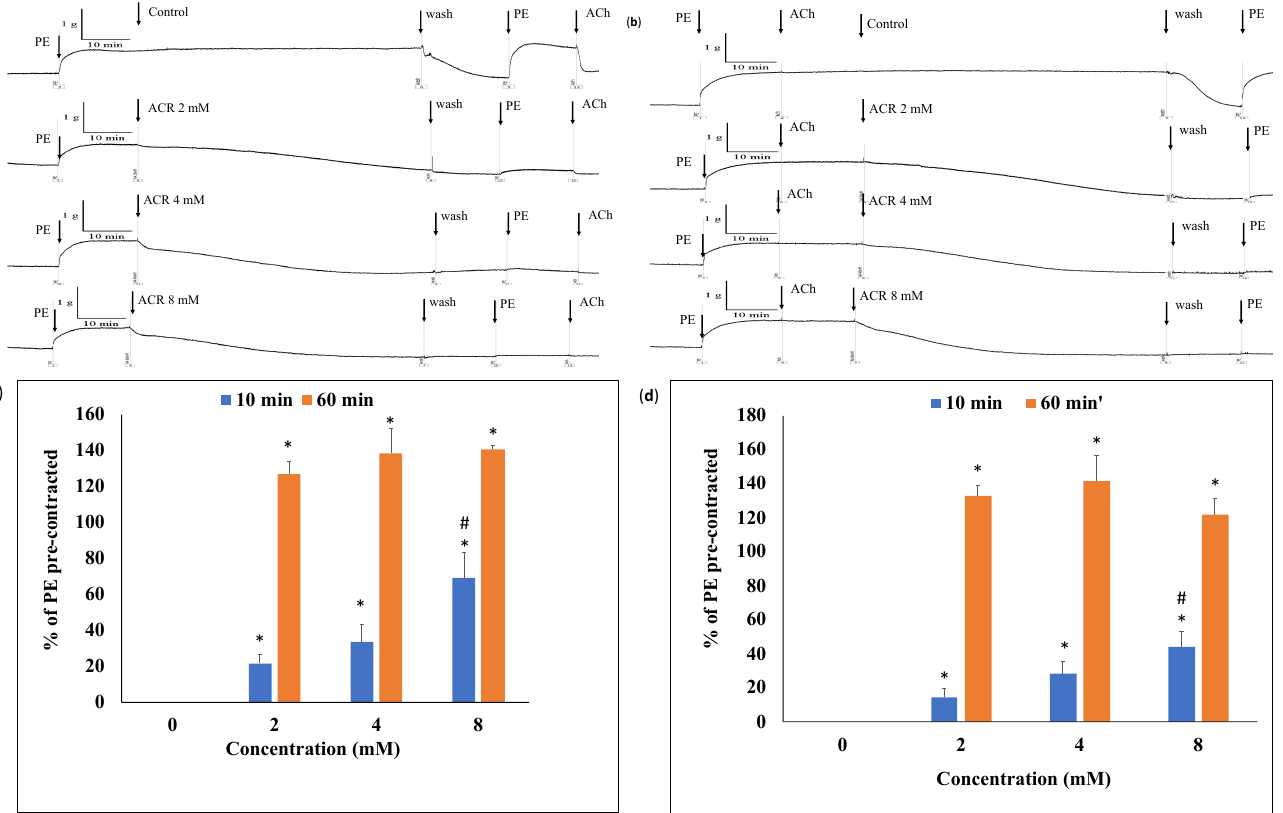
Figure 3. Effects of acrylamide (ACR) on endothelium-intact ( a , c ) and endothelium-denuded ( b , d ) aortic rings. Aortic rings were precontracted using phenylephrine (PE) (2 µ M) for 15 min, and the control (ACR 2, 4, and 8 mM) was added to the aortic rings. The samples were individually recorded for 60 min. (*: significant difference vs. control, p < 0.05; #: significant difference between ACR 4 mM and ACR 8